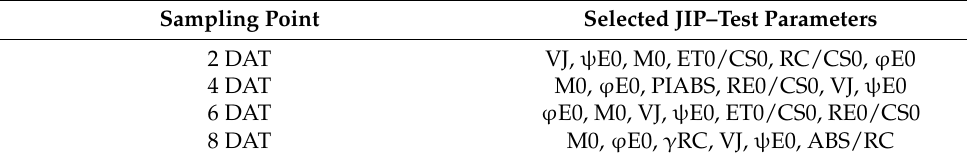
Table 2. Optimal features selected by PCA loading for each sampling day. They were listed in order of importance. DAT, days after treatment.